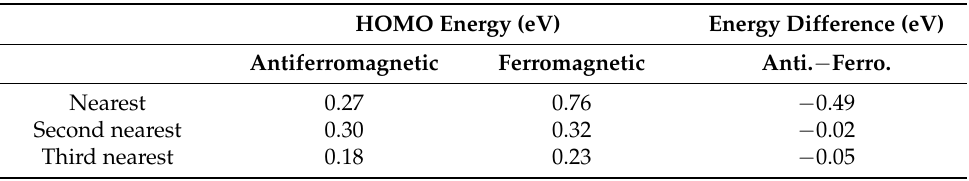
Table 3. Difference in the HOMO energies between antiferromagnetic and ferromagnetic configura- tions in the Fe–Fe